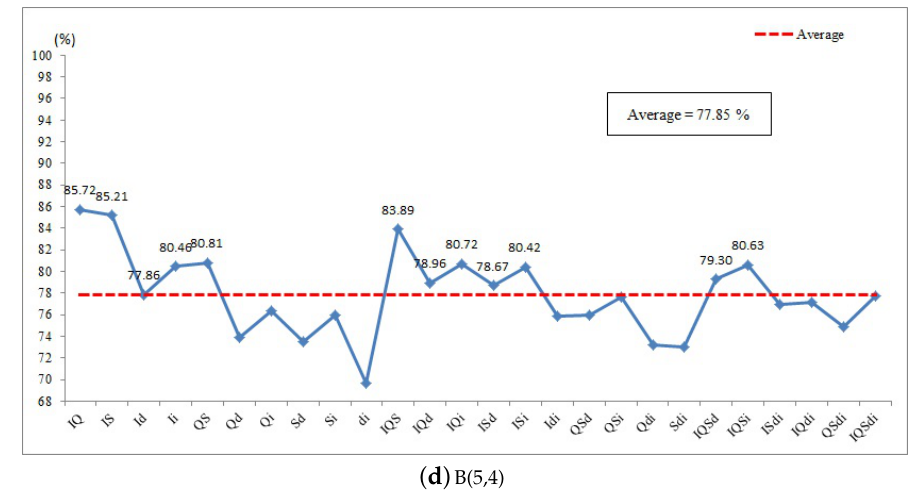
Figure 11. Performance of the combination of 5-feature sets (B group) using